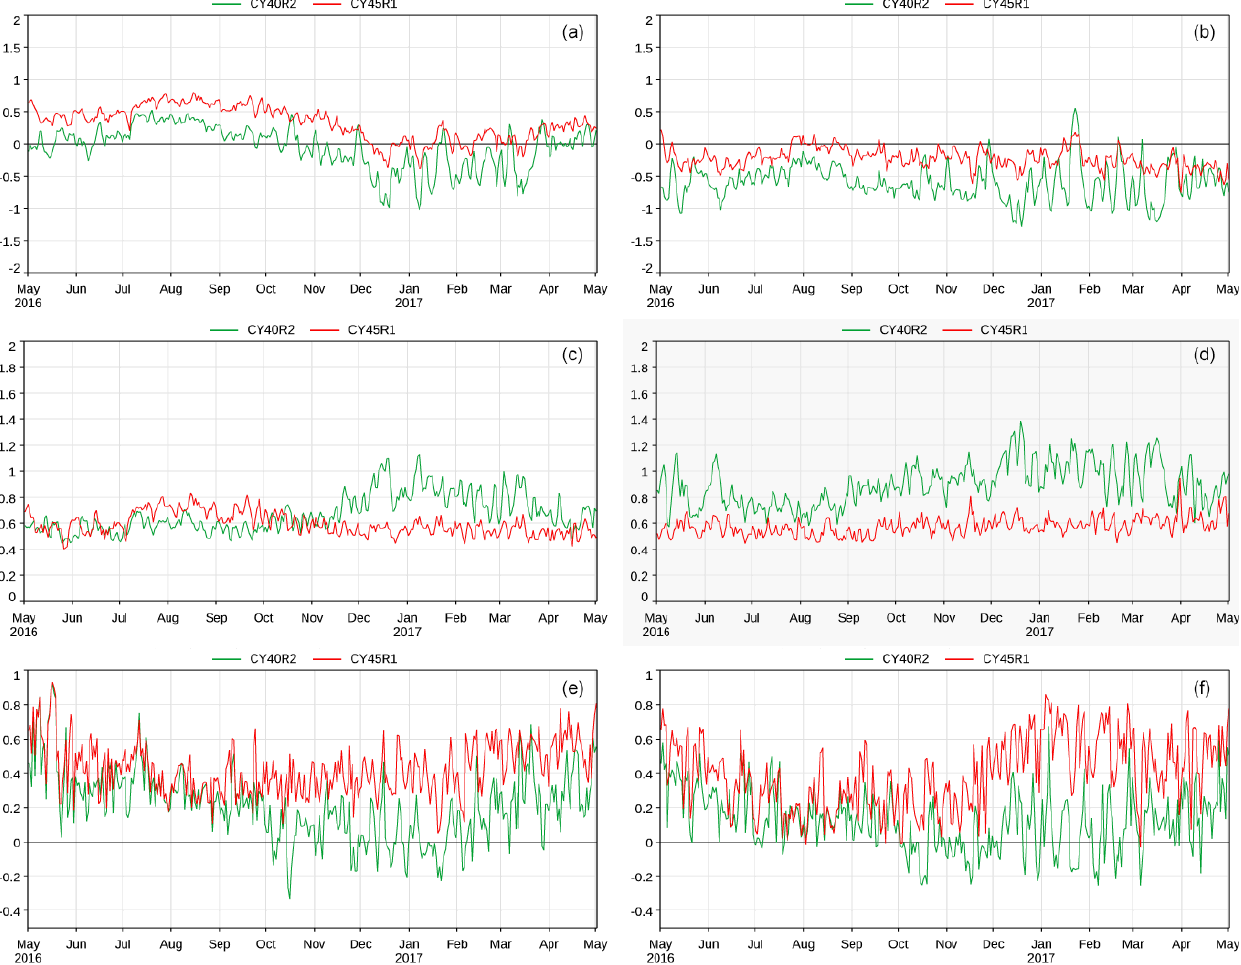
Figure 15. MNMB (a, b) , FGE (c, d) , and spatial correlation (e, f) of daily near-surface PM 2 . 5 (a, c, e) and PM 10 (b, d, f) (µgm − 3 ) simulated by cycles 40R2 (green) and 45R1 (red) against observations in the United States from the AirNow